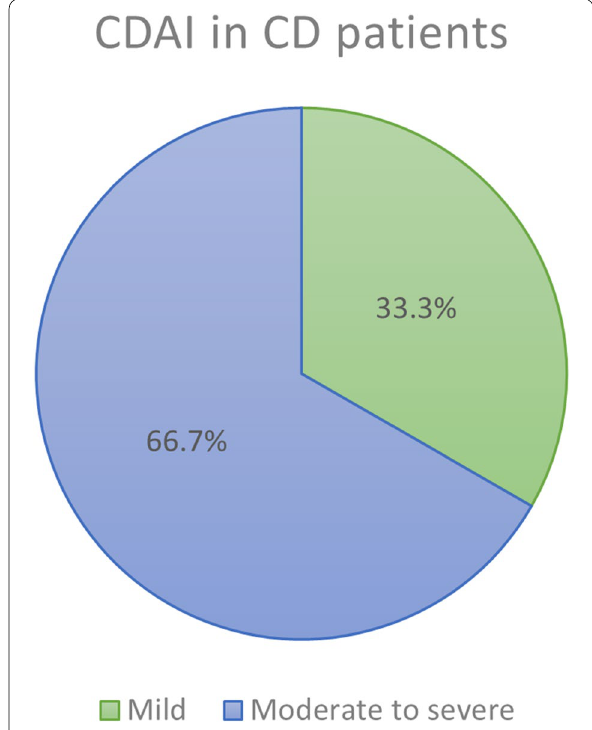
Fig. 6 Degree of severity of Crohn’s disease (Crohn’s Disease Activity Index) at index